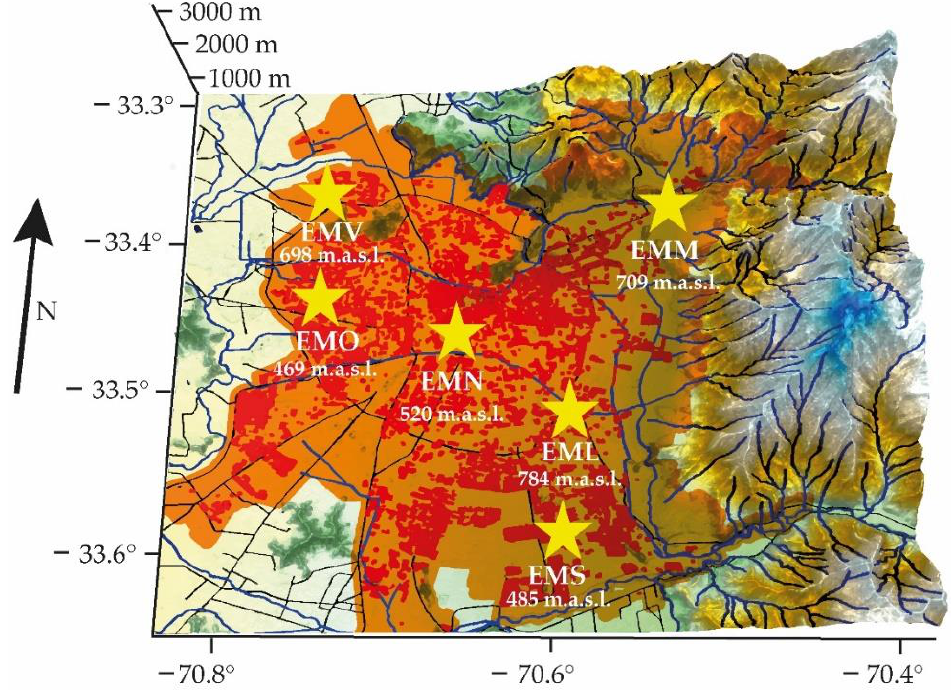
Figure 2. Geographical distribution of the monitoring stations for this study (yellow stars network) and high construction population density (red color for the network of areas with the highest population density).